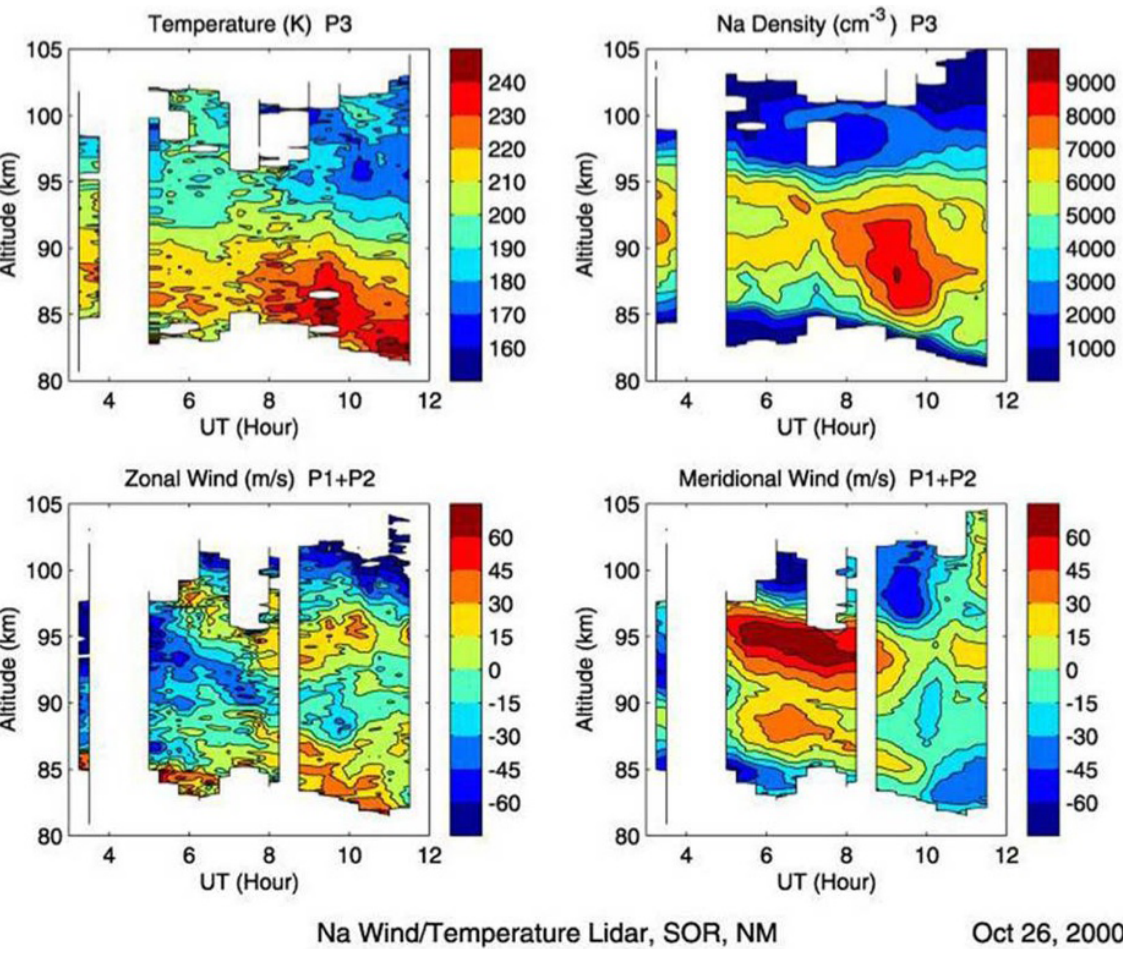
Fig. 7. Contour plots as a function of time and altitude of the temperature, sodium density, zonal winds, and meridional winds measured with the Starfire lidar on 26 October